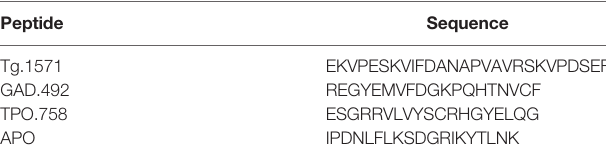
TABLE 1 | Sequence of peptides used in ELISA screening or immunizations. Peptide Sequence